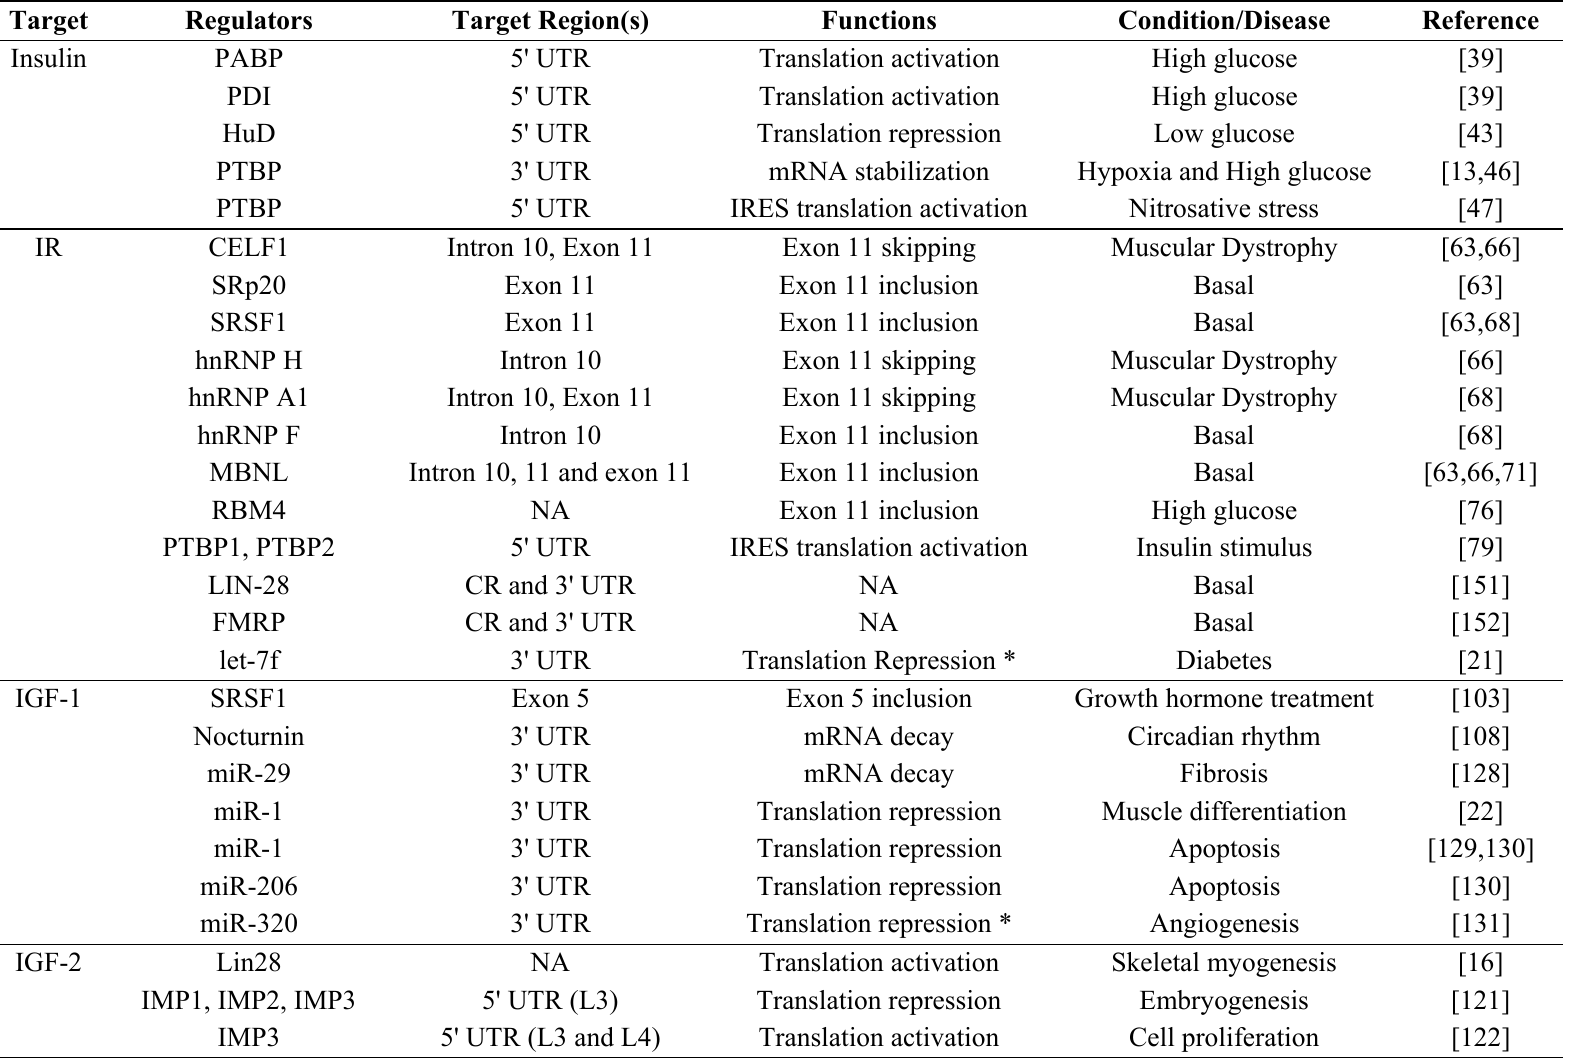
Table 1. Posttranscriptional regulators of insulin family ligands and their